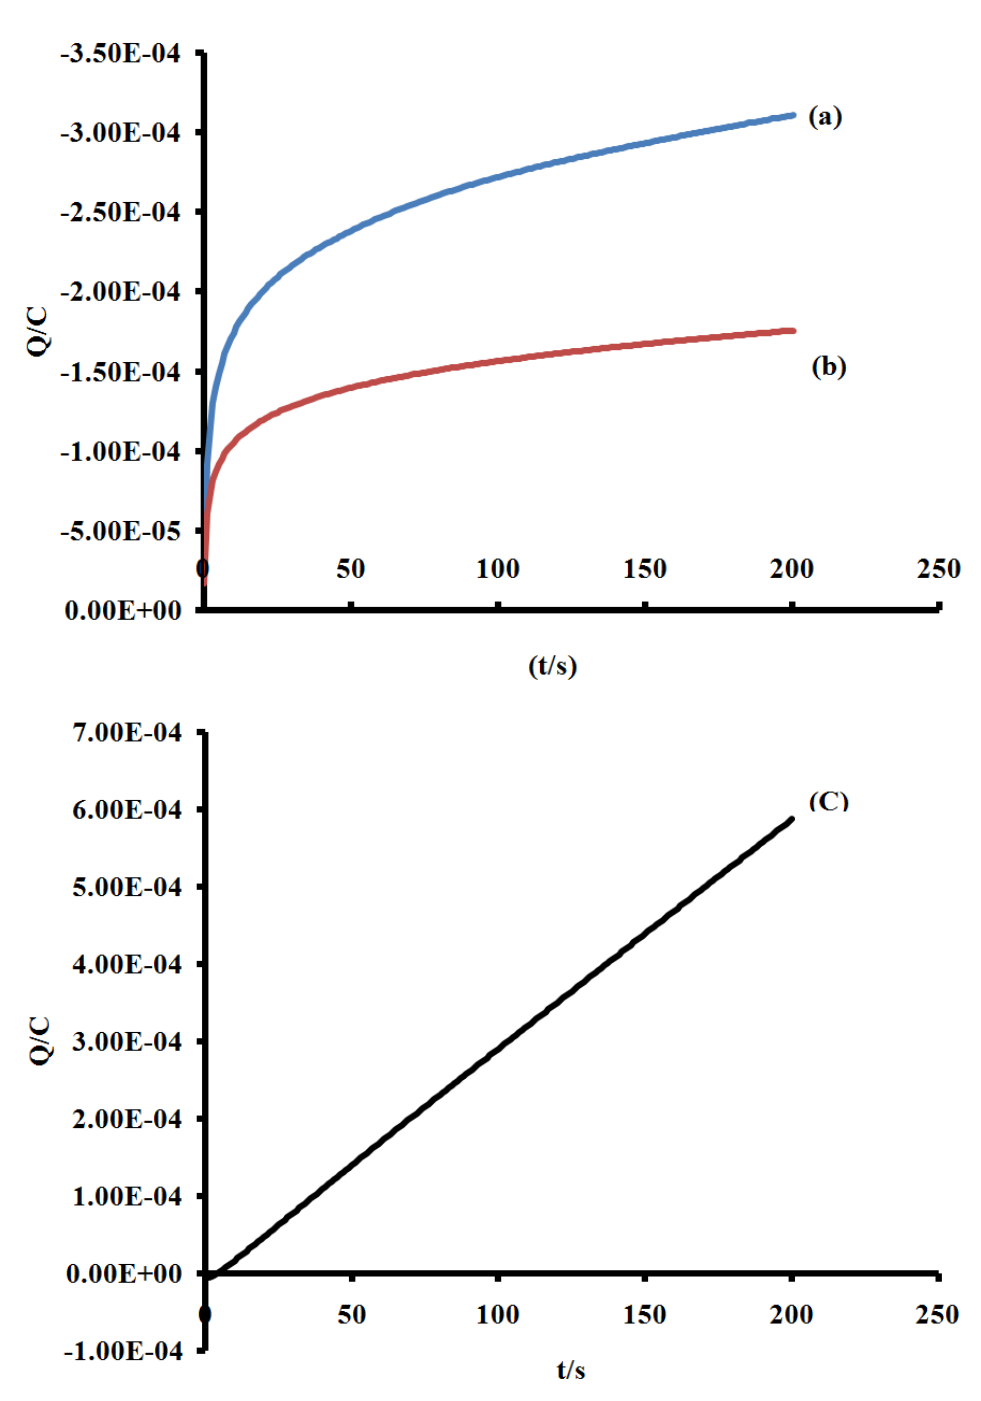
Figure 6. Plots of charge vs . time response for processes I , II and III ; (line a–c, respectively). Scan rate = 200 m Vs − 1